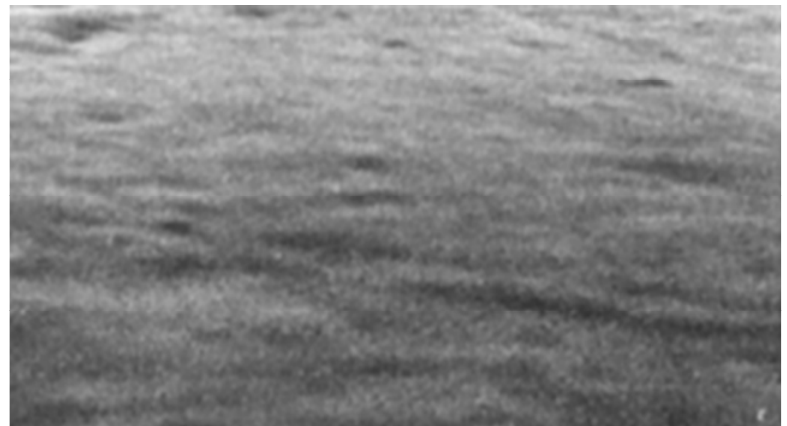
Figure 4. Scanning electron microscopy images of PoAP film (thicknes 69 nm) deposited on the rotating disc gold electrode. Reprinted from [14] with permission from Elsevier.